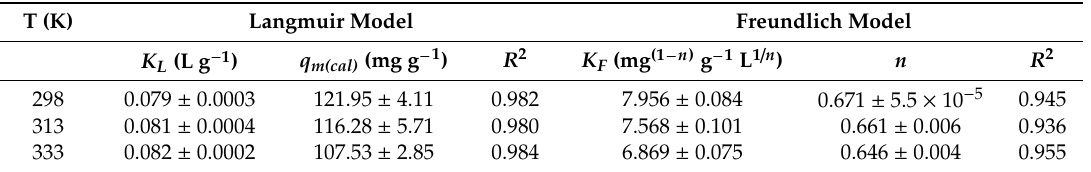
Table 3. Parameters of Langmuir and Freundlich isotherm adsorption model, considering di ff erent temperatures.